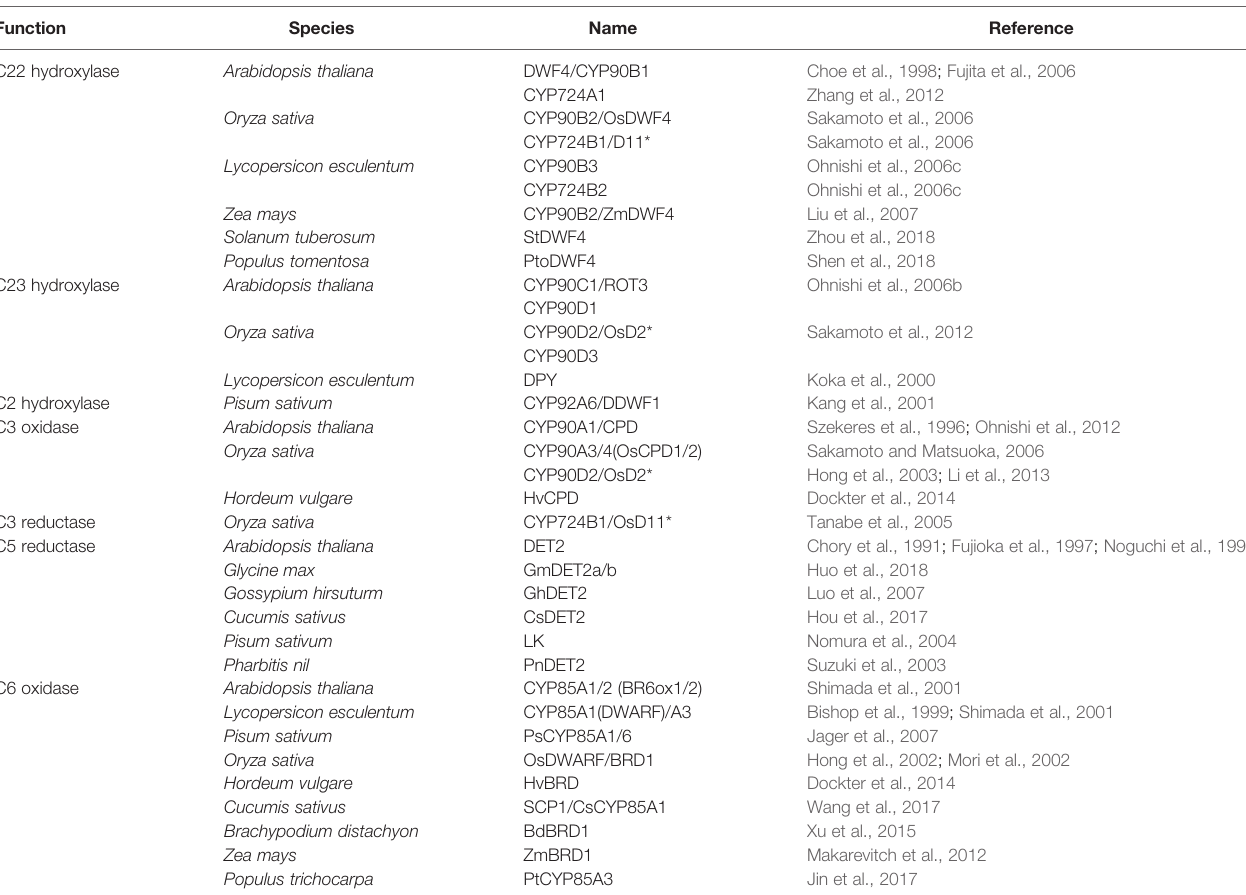
TABLE 2 | Speci fi c BR biosynthesis enzymes identi fi ed in different plant species.